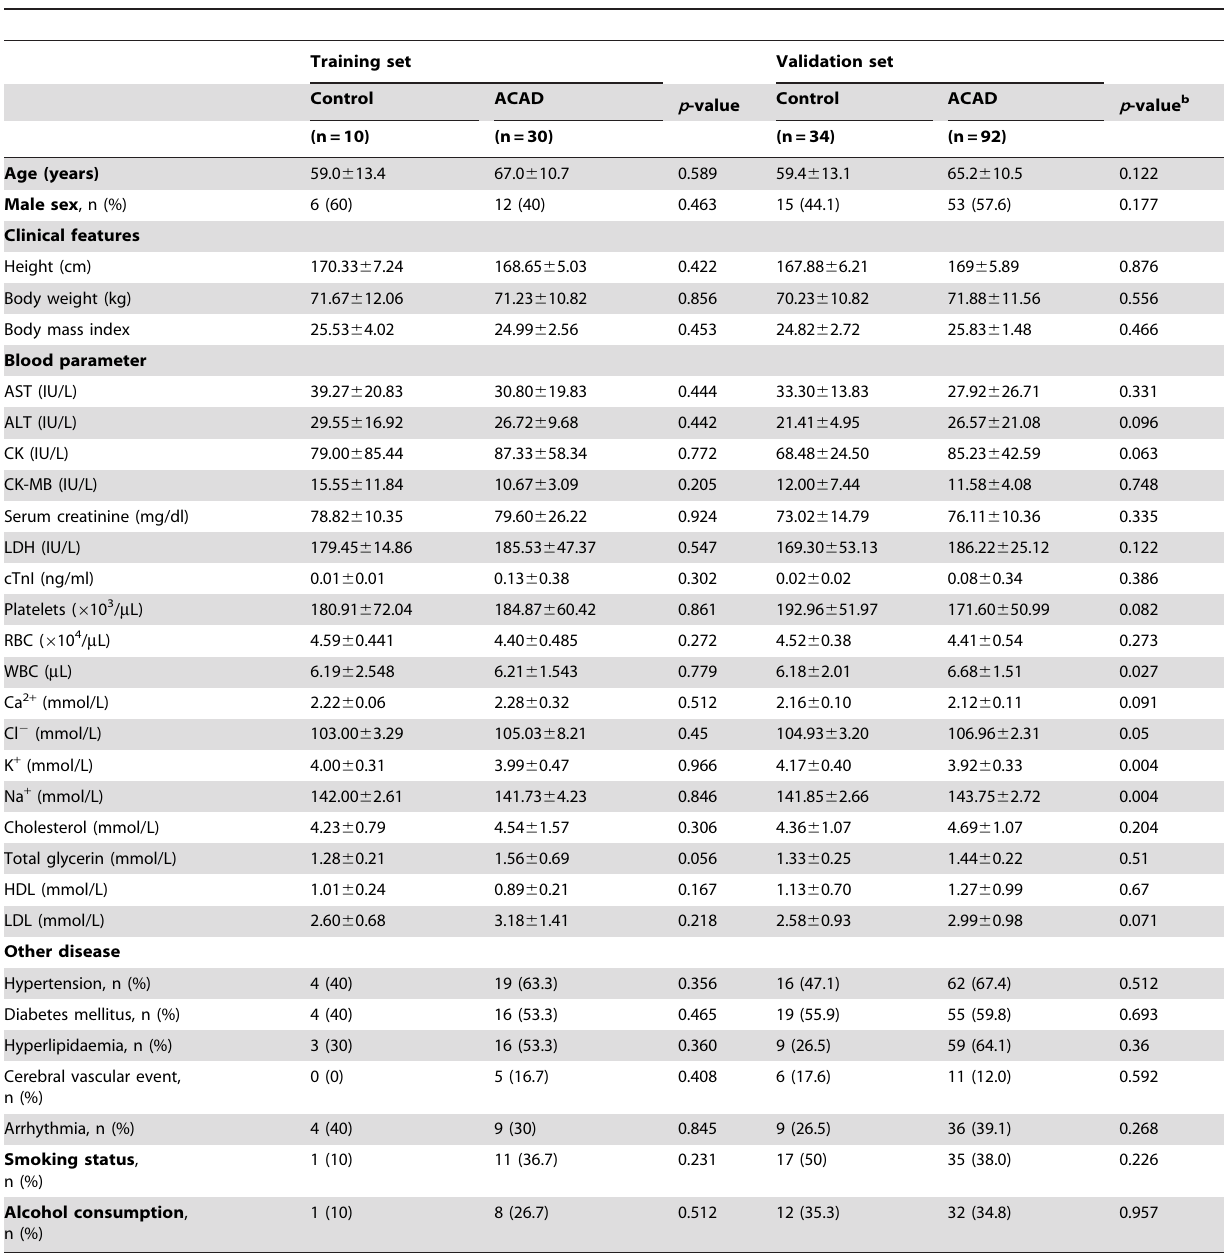
Table 1. Demographic and clinical features of the Atypical coronary artery disease (ACAD) patients and controls in the training set and validation set a